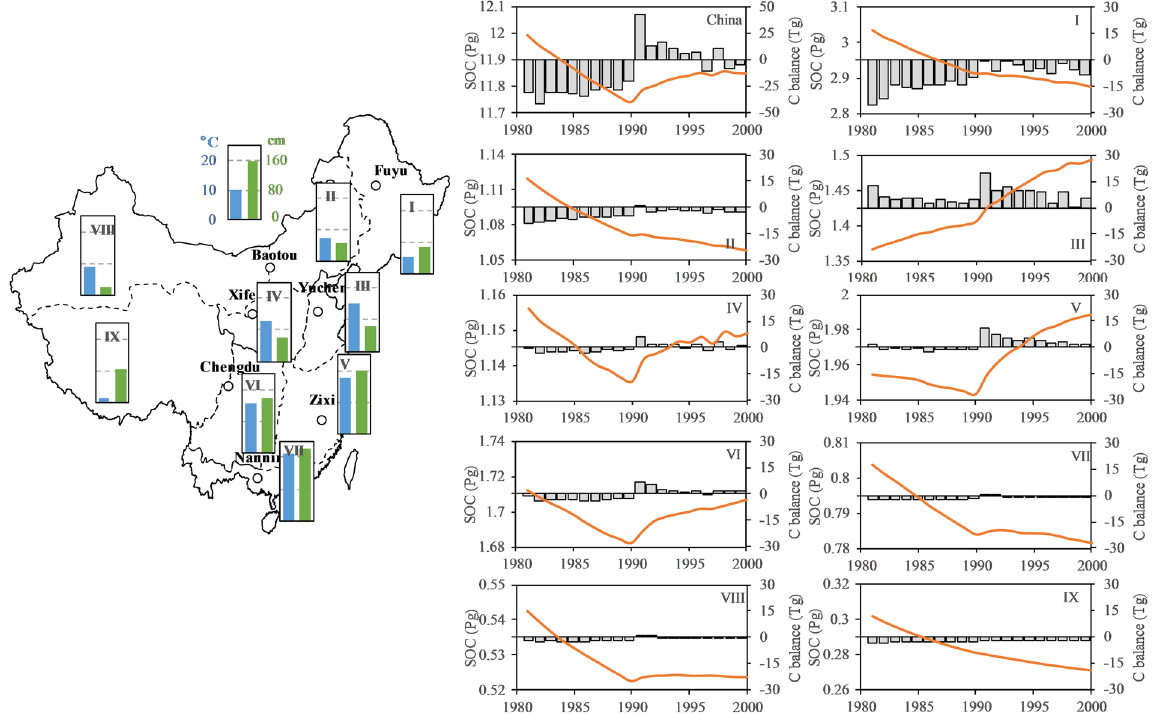
Figure 2. SOC change on cropland in China and in the 9 agricultural divisions. I, the northeastern region; II, Inner Mongolia and the area along the Great Wall; III, Huanghuai; IV, the Loess Plateau; V, the lower and middle reaches of the Yangtze River; VI, the southwestern region; VII, South China; VIII, Gansu-Xinjiang; and IX, the Qinghai-Tibetan area. The color of the map represents the extent of multiple cropping; the darker color indicates a higher proportion of multiple cropping. The floating bar graphs show the average annual temperature and precipitation in the region. The white points on the map of China show that the seven validation sites were located in different provinces and belong to different agro-ecosystem divisions. The figure was generated using Microsoft excel 2016 software provided by Microsoft